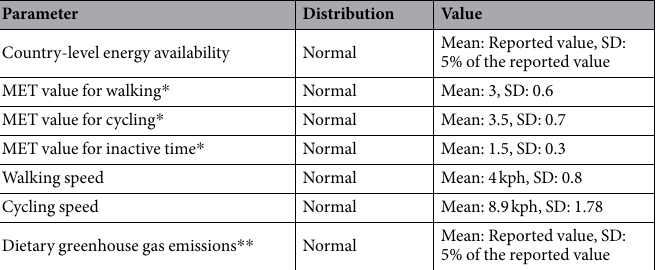
Table 1. Distributions around key parameters used in the analysis. MET: Metabolic equivalent of task. SD: Standard deviation. * We assumed the SD was 20% of the mean value and then checked that the resulting distributions corresponded with the range expected from the MET values associated with these activities. ** We assumed correlated uncertainty at the study level between greenhouse gas emissions and energy